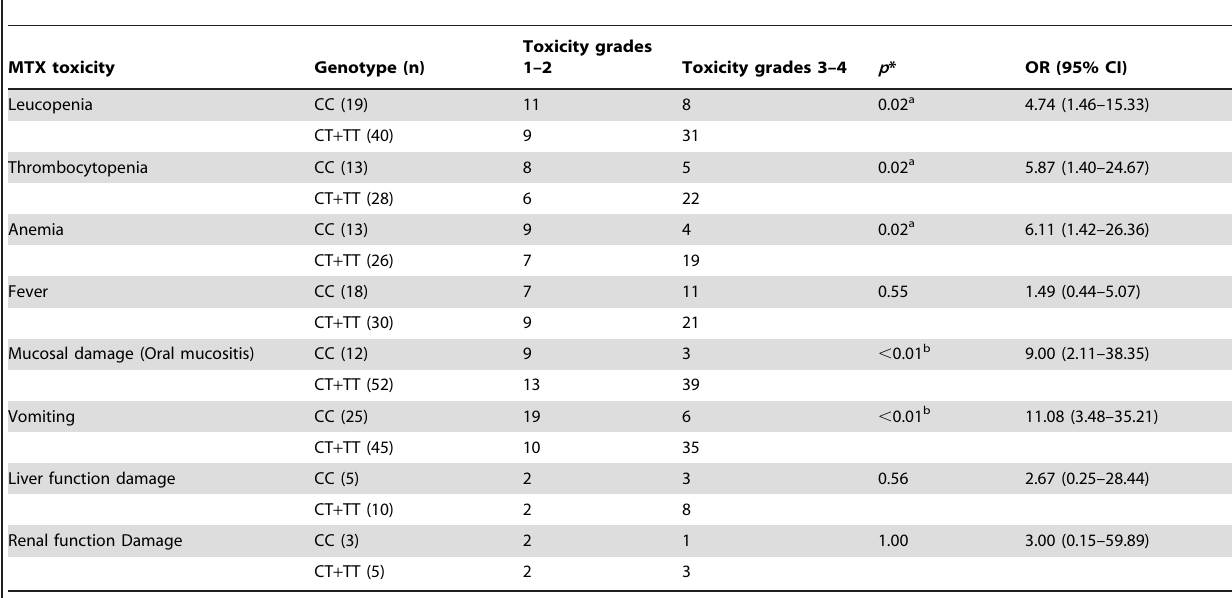
Table 5. Association of ATP-binding cassette subfamily C member 2 ( ABCC2 ) gene 2 24C . T genotype with methotrexate (MTX) toxicity